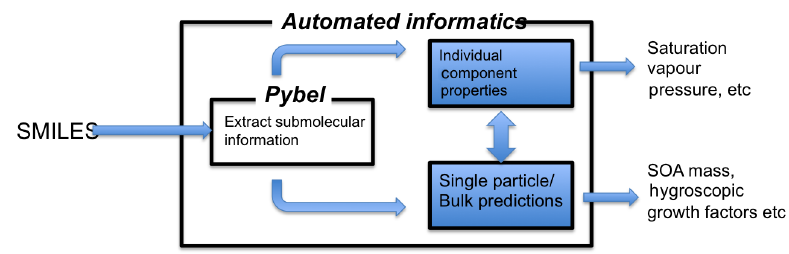
Figure 1. Workflow of calculations based on SMILES representation and the Pybel parsing module.